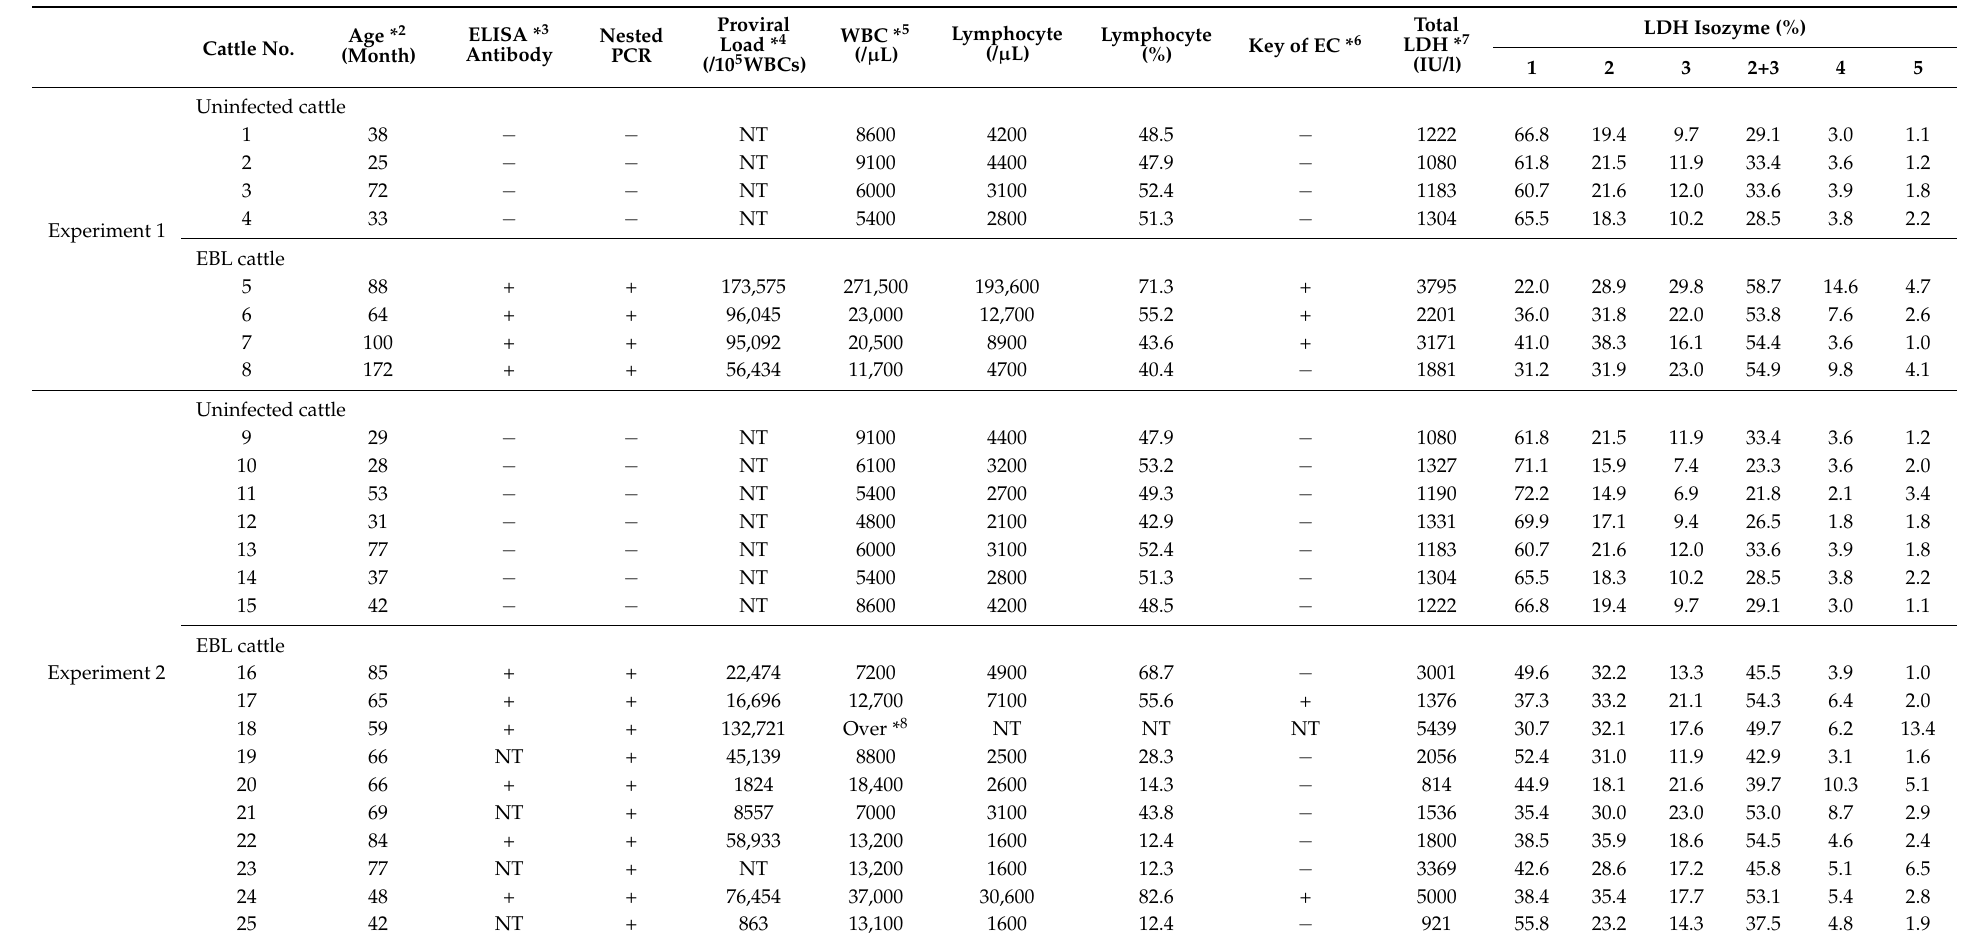
Table 1. Clinical status of cattle used in this study * 1